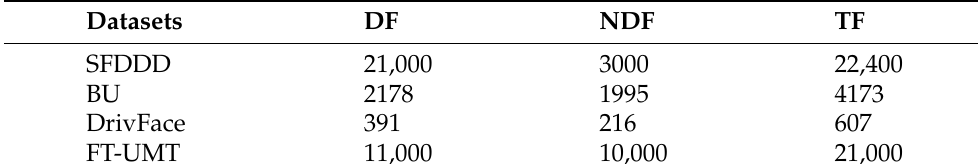
Distracted and not distracted frames in four datasets, namely: (i) SFDDD, (ii) BU, (iii) DrivFace, and (iv) FT-UMT. DF = Distracted Frames, NDF = Not Distracted Frames, TF = Total Frames.